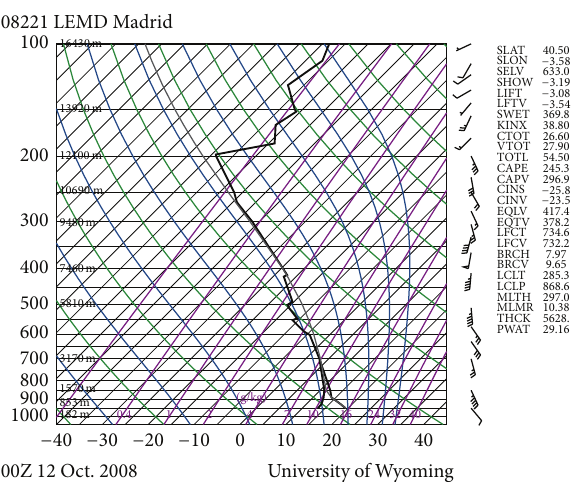
Figure 4: Skew- 𝑇 diagram of Madrid for 12 October 2008 at 0000 UTC Madrid (http:/weather.uwyo.edu/upperair/sounding .html).